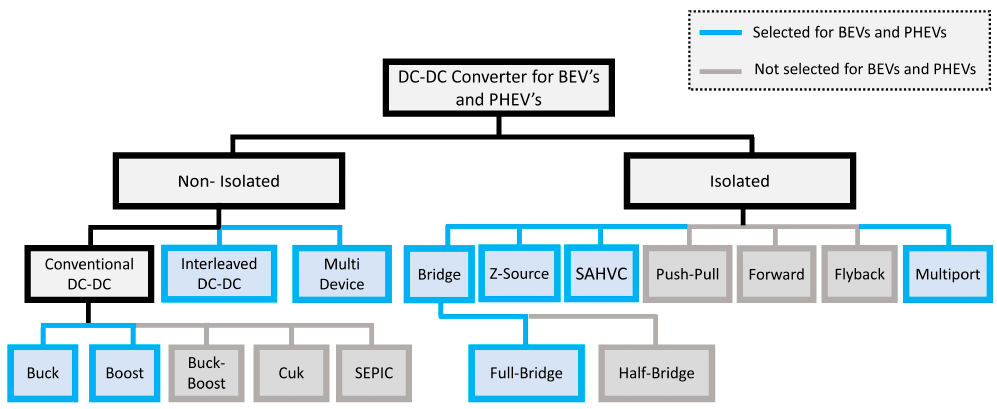
Figure 21. Classification of DC–DC converter topologies